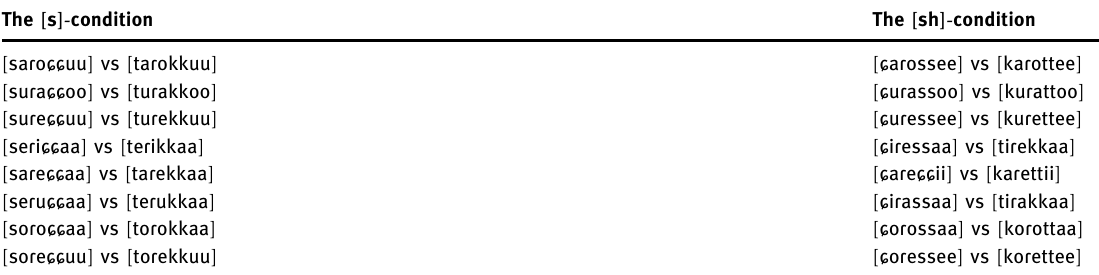
Table 1: The list of stimuli used in the experiment. [ ɾ ] represents an alveolar fl ap. [ ɕ ] represents a voiceless alveolo - palatal fricative The [ s ]-